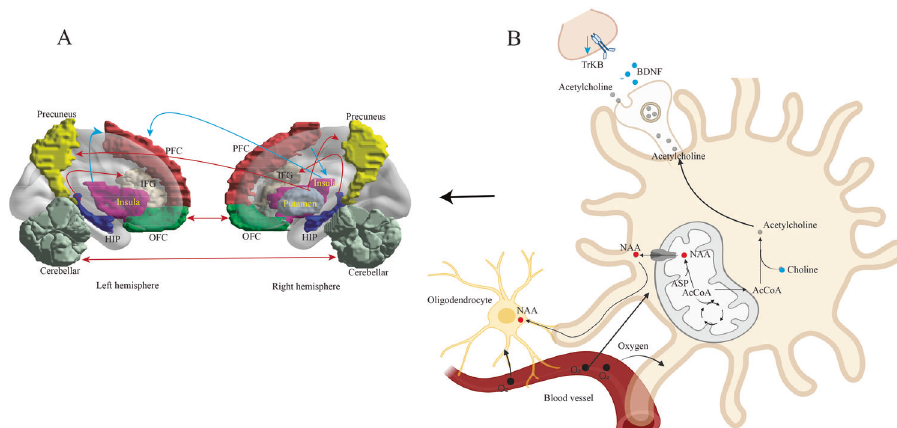
Fig. 3 The relationship between neurometabolic changes and alternations of brain functional connectome in bipolar disorder (BD) compared to MDD. A Differences in brain functional connectome between BD and MDD. The red connections indicated increased functional connectivity (FC) between two brain regions in patients with BD, and the blue connections indicated decreased FC in BD patients. B Changes of brain neurotransmitters and their receptors and BDNF in ACC, right prefrontal lobe, and OFC of BD patients compared to MDD. Blue dots and arrows indicated decreased levels, and red dots indicated increased levels in BD patients compared to MDD. IFG, inferior frontal gyrus; OFC, orbitofrontal cortex; PFC, prefrontal cortex; HIP, hippocampus; NAA, N-Acetylaspartic acid; BDNF, brain-derived neurotrophic